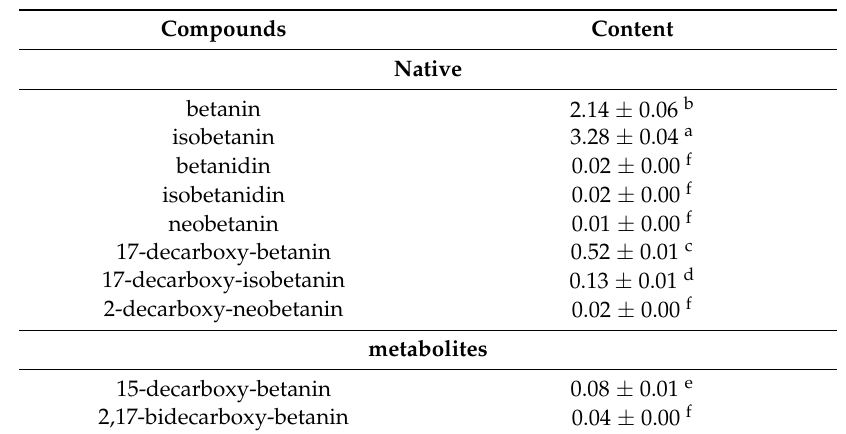
Table 2. Content of betalains in rat plasma samples ( µ